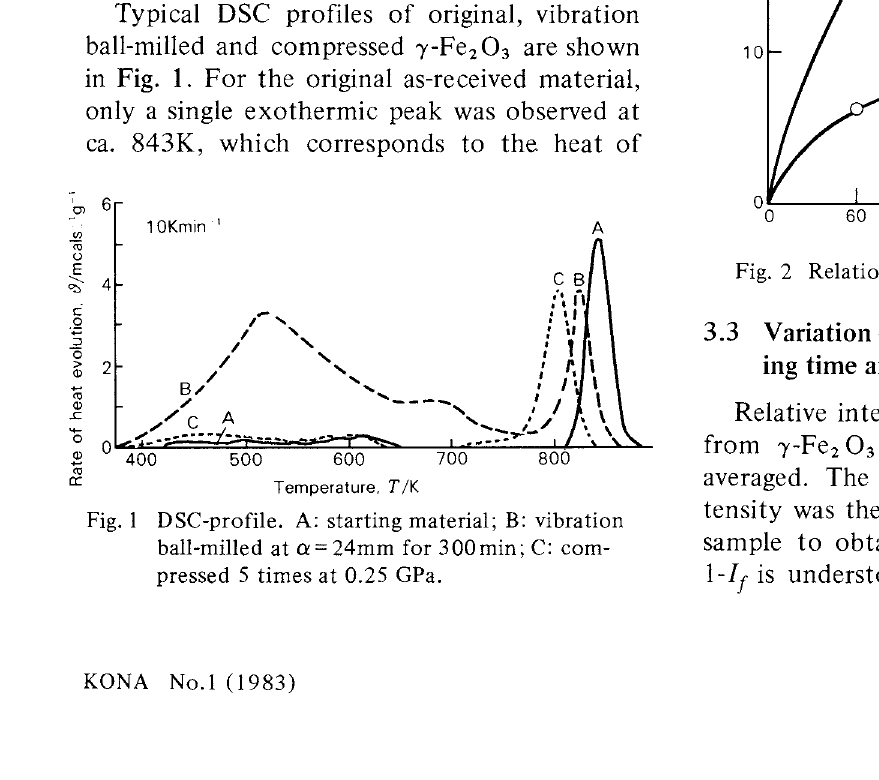
Fig. 2 Relation between M* and grinding